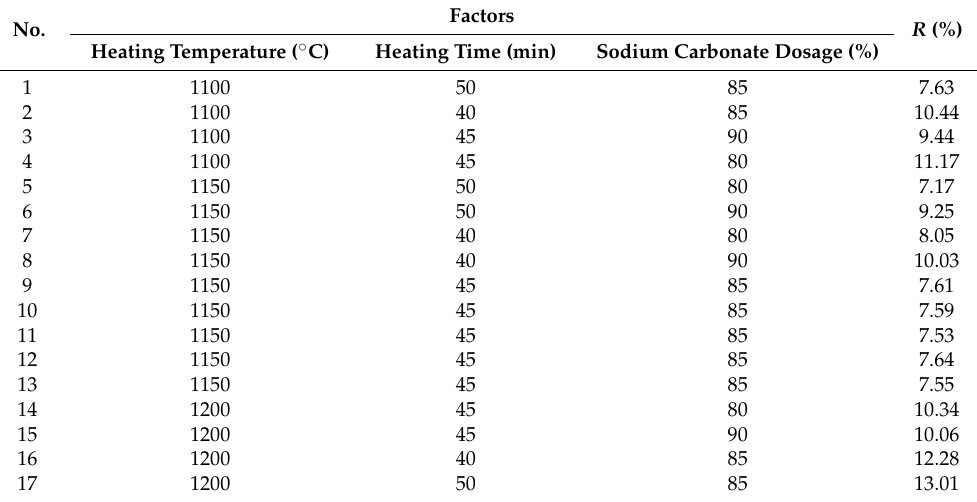
Table 4. Box–Behnken design and experimental results.